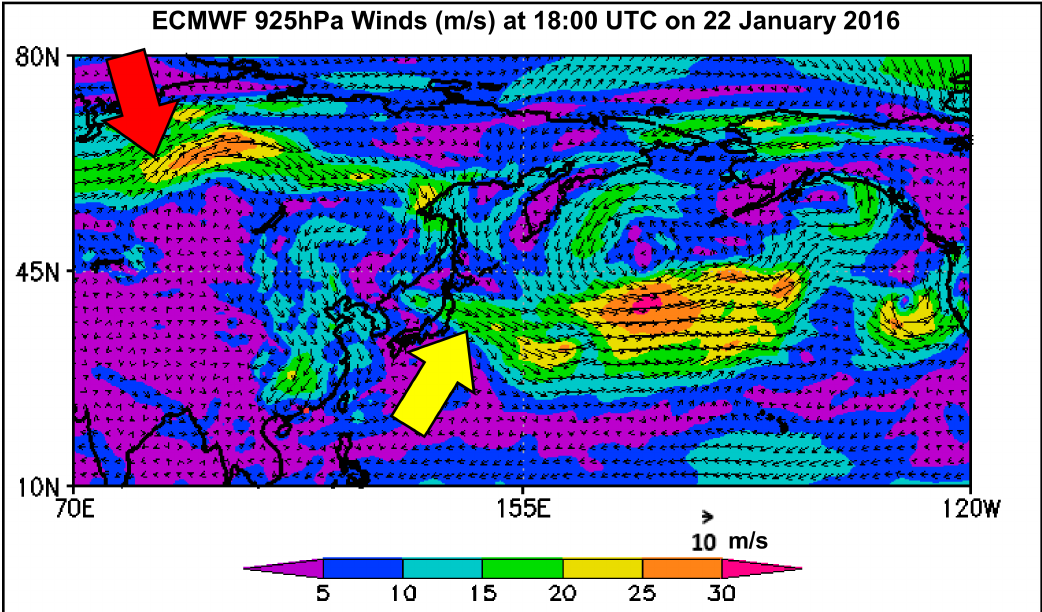
Figure 4. ECMWF 925 hPa winds (m/s) at 18:00 UTC 22 January 2016 over the SH and AL domain. Red and green arrows show progression of winds from Arctic Circle towards AL. Data from the ECMWF,